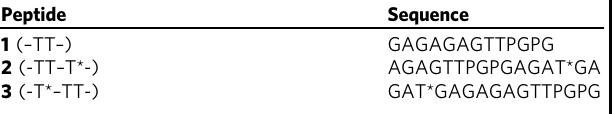
Table 1 Peptide acceptor substrates used in this study Peptide Sequence